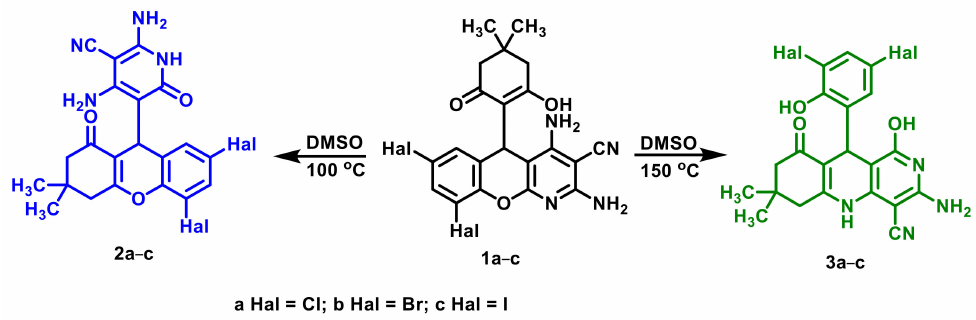
Scheme 2. Thermal rearrangement of 7,9-dihalogen-substituted 5-(2-hydroxy-6-oxocyclohexyl)-5 H - chromeno[2,3- b ]pyridines 1 .